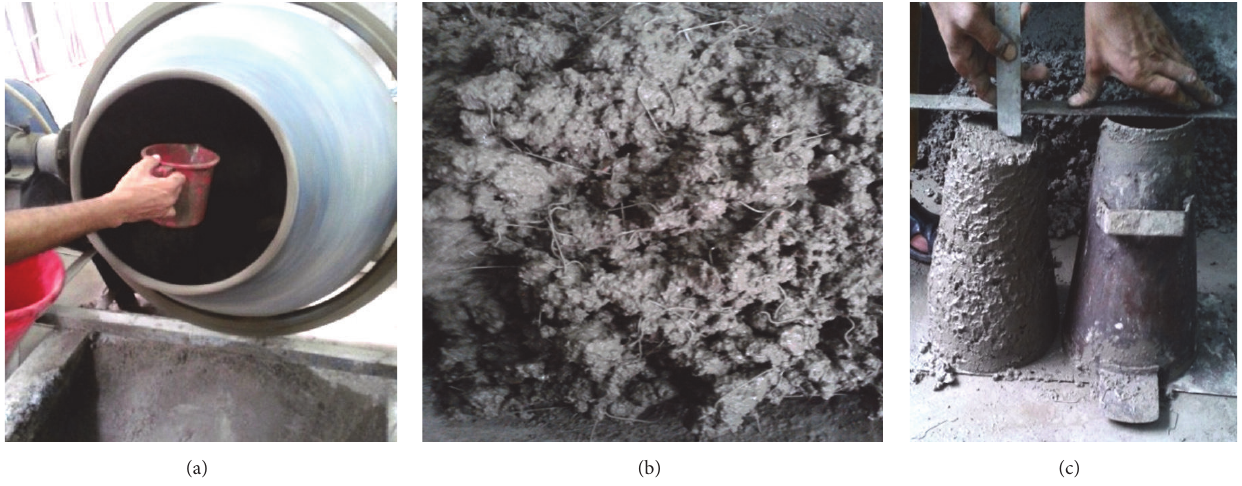
Figure 3: (a) Concrete mixing, (b) after mixing, and (c) slump test.